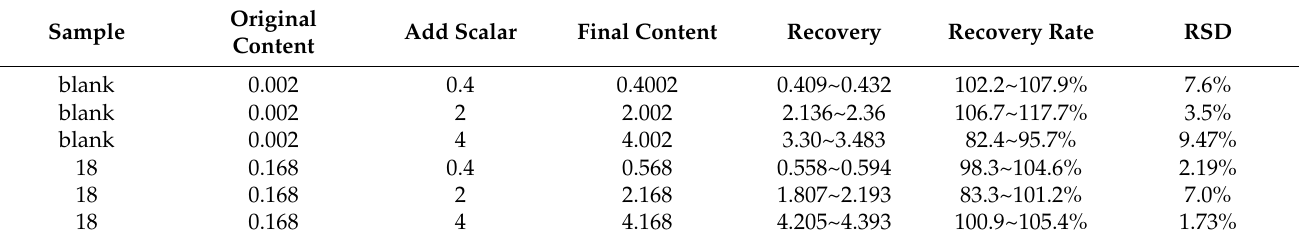
Table 5. Recovery of fluorescent probe detecting Mn 2+ .